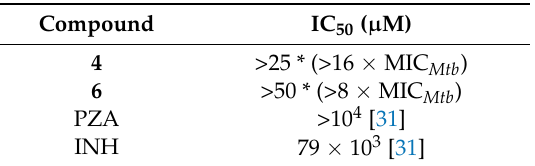
Table 2. Cytotoxicity of the tested substances in HepG2 cells.